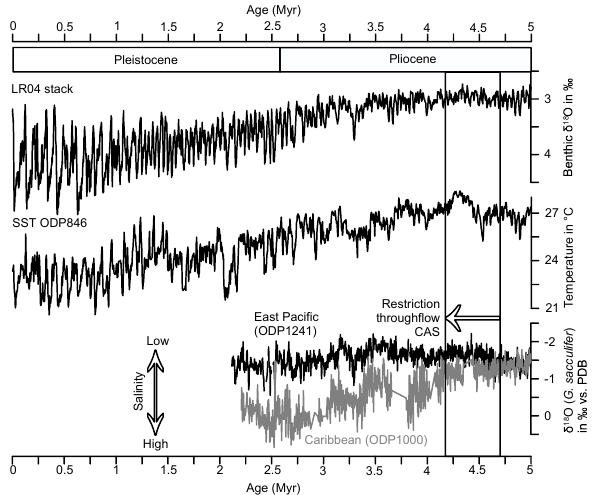
Figure 1. LR04 global stack of benthic δ 18 O reflecting changes in global ice volume and temperature (Lisiecki and Raymo, 2005). (cid:48) U K sea-surface temperature (SST) of ODP Site 846 in the equa- 37 torial Pacific cold tongue (Lawrence et al., 2006). δ 18 O of the planktonic foraminifer G. sacculifer from ODP Site 1000 in the Caribbean and ODP Site 1241 in the eastern Pacific (Haug et al., 2001; Steph, 2005; Steph et al., 2006a), reflecting changes in sea- surface salinity (see Fig. 2 for location of ODP sites). The box rep- resents the time window analyzed in this